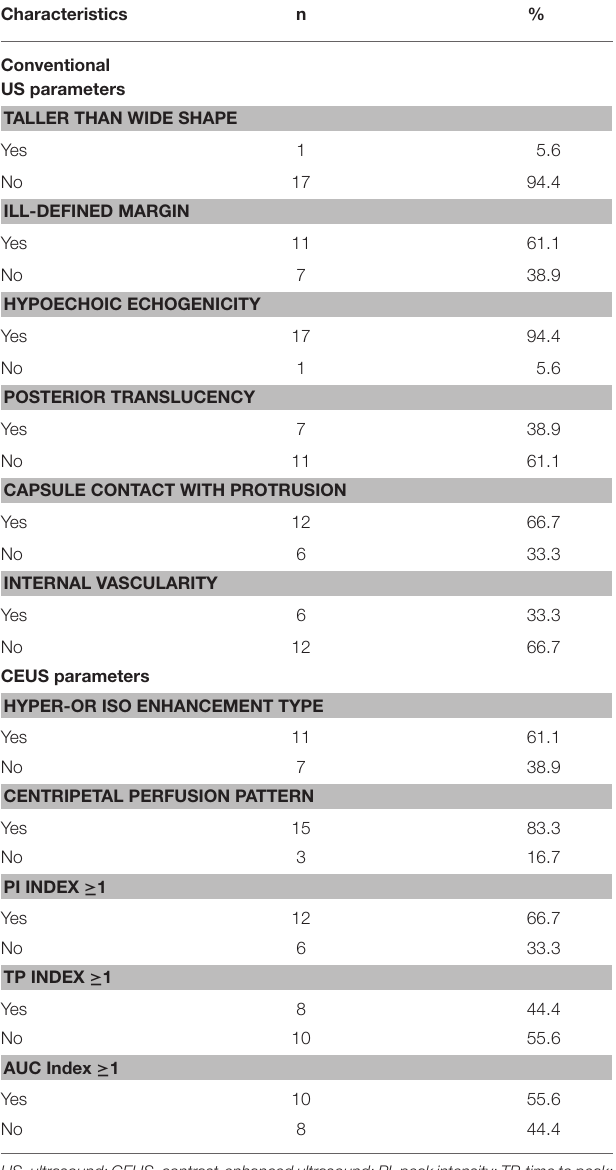
TABLE 1 | Clinical